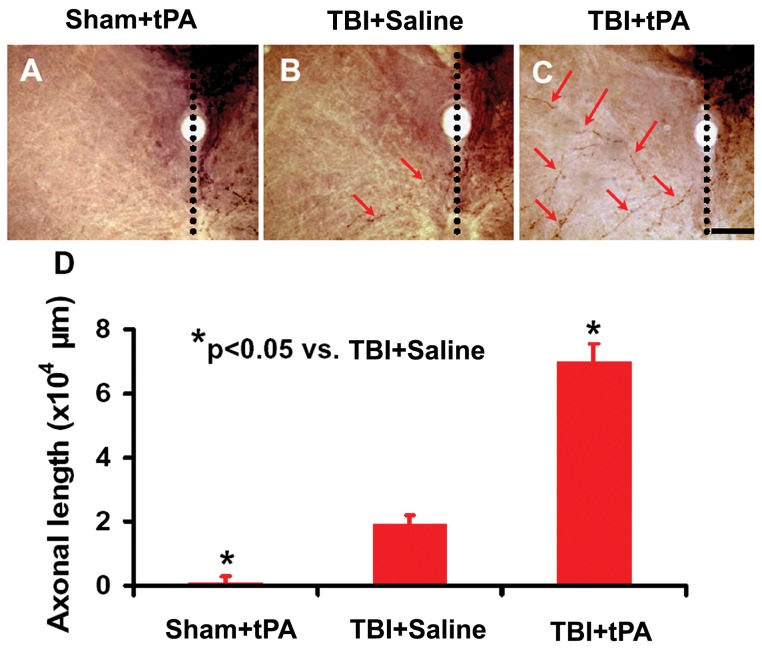
BDA-labeling of CST originating from the contralesional intact hemisphere.Representative images from the cervical spinal cord show BDA-labeled CST axons crossing the midline (arrows in B) and sprouting into the denervated side of the ventral gray matter in a rat after TBI. tPA treatment significantly increased the axon midline crossing (arrows in C). There were no obvious BDA-labeled axons observed in the opposite side of the cervical spinal cord in sham rats (A). Quantitative data (D) show that the number of contralesional CST in the denervated cervical gray matter was increased significantly by traumatic injury (p<0.05 vs. Sham+tPA) and tPA treatment (p<0.05 vs. TBI+Saline). Scale bar  = 50 µm. Data represent mean ± SD. n = 8 (rats/group).